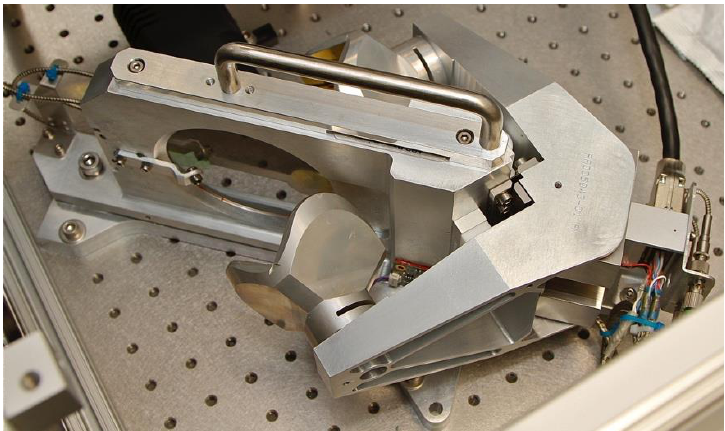
Figure 4. The ABB Generic Interferometer for Climate Studies (GICS) shown here during post-delivery testing at the University of Wisconsin-Madison Space Science and Engineering Center (UW-SSEC) was selected for the ARI interferometer core.